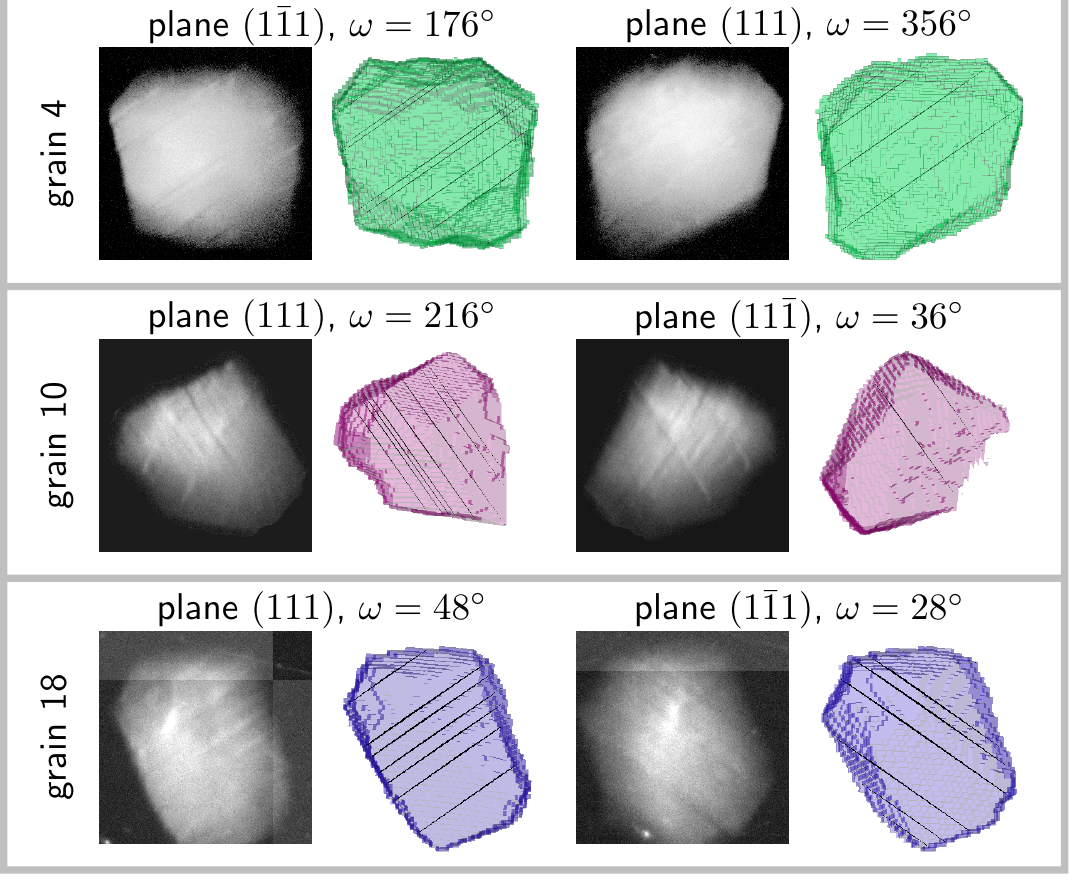
Figure 6. Identification of the bands as slip plane traces visible in the edge-on geometrical configuration in the topographs; here, the two observed active slip planes are shown for one of the two ω angles; the active slip plane locations within the grains have been measured manually and displayed in